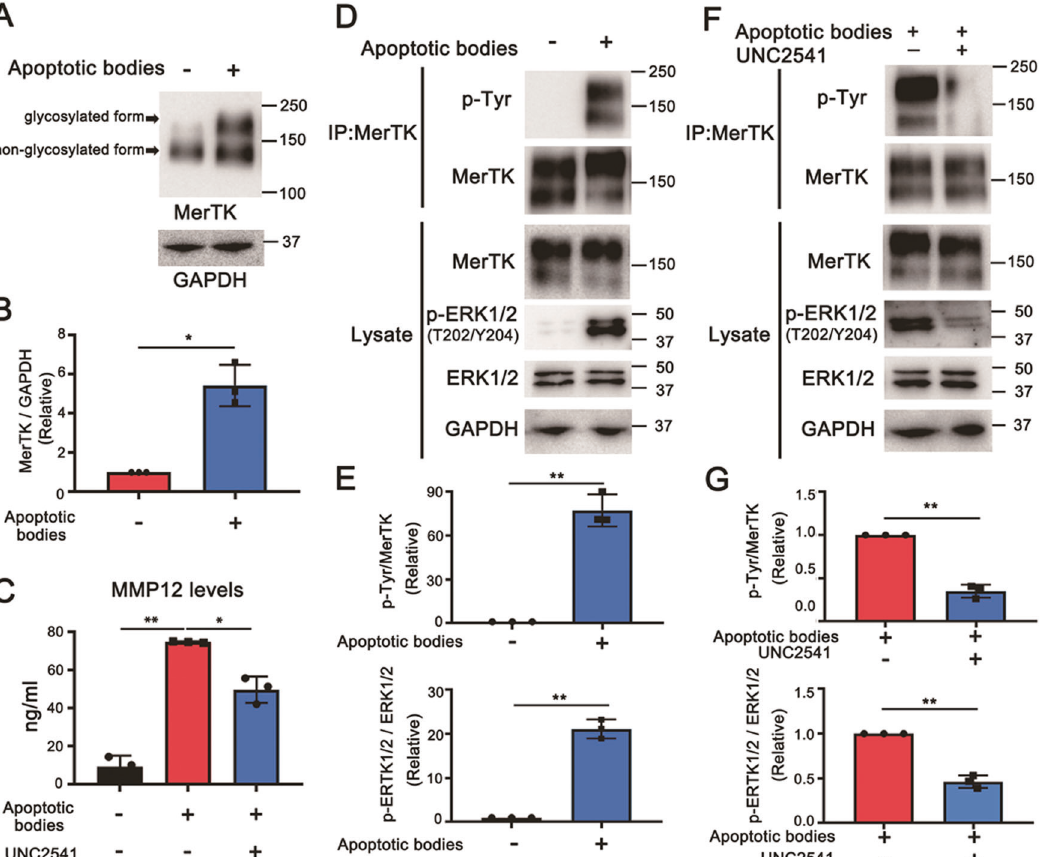
Fig. 7 Examination of the activation of the MerTK signaling pathway in Ly6C lo macrophages induced by BM-MSC-derived apoptotic bodies. A – B Detection and semi-quanti fi cation of MerTK proteins from BMDMs (1 × 10 6 ) with or without stimulation of BM-MSC-derived apoptotic bodies (3 × 10 7 ) for 30 min. Mouse MerTK is heavily glycosylated (15 N-glycosylation sites), the expression of MerTK with a 180 Kd glycosylated and 130 Kd non-glycosylated form were detected by Western blot ( A ) and ImageJ software ( B ) analyses ( n = 3). C Examination of the inhibition of the MerTK signaling pathway in BMDMs by using UNC2541 inhibitor. MMP12 expression was detected as a downstream event for the activation of the MerTK signaling pathway. The secreted MMP12 protein was collected from the culture supernatant of BMDMs treated with mock PBS (control) or apoptotic bodies (3 × 10 7 ) in combination with UNC2541 (1 μ M) or without UNC2541 and detected by ELISA ( n = 3). D – E Detection and semi-quanti fi cation of the phosphorylation of MerTK and ERK1/2 in BMDMs (1 × 10 6 ) with or without stimulation of BM-MSC-derived apoptotic bodies (3 × 10 7 ) by immunoprecipitation/Western blot ( D ) and ImageJ software ( E ) analyses ( n = 3). The immunoprecipitation assay was performed by using anti-MerTK mAb, and phosphorylated MerTK was analyzed by Western blot assay with an HRP-conjugated anti-phosphotyrosine mAb. F , G Detection and semi-quanti fi cation of the phosphorylation of MerTK and ERK1/2 in BMDMs (1 × 10 6 ) upon stimulation of BM-MSC-derived apoptotic bodies (3 × 10 7 ) in combination with UNC2541 (1 μ M) or without UNC2541 by immunoprecipitation/Western blot ( F ) and ImageJ software ( G ) analyses ( n = 3). The immunoprecipitation and Western blot assays were performed followed by the methods as described in experiment D. Bars = ± SD. Statistical evaluation of two groups was performed using an independent Student t -test. Statistical evaluation of multiple groups was performed using one-way ANOVA with posthoc LSD test; * p < 0.05, ** p <